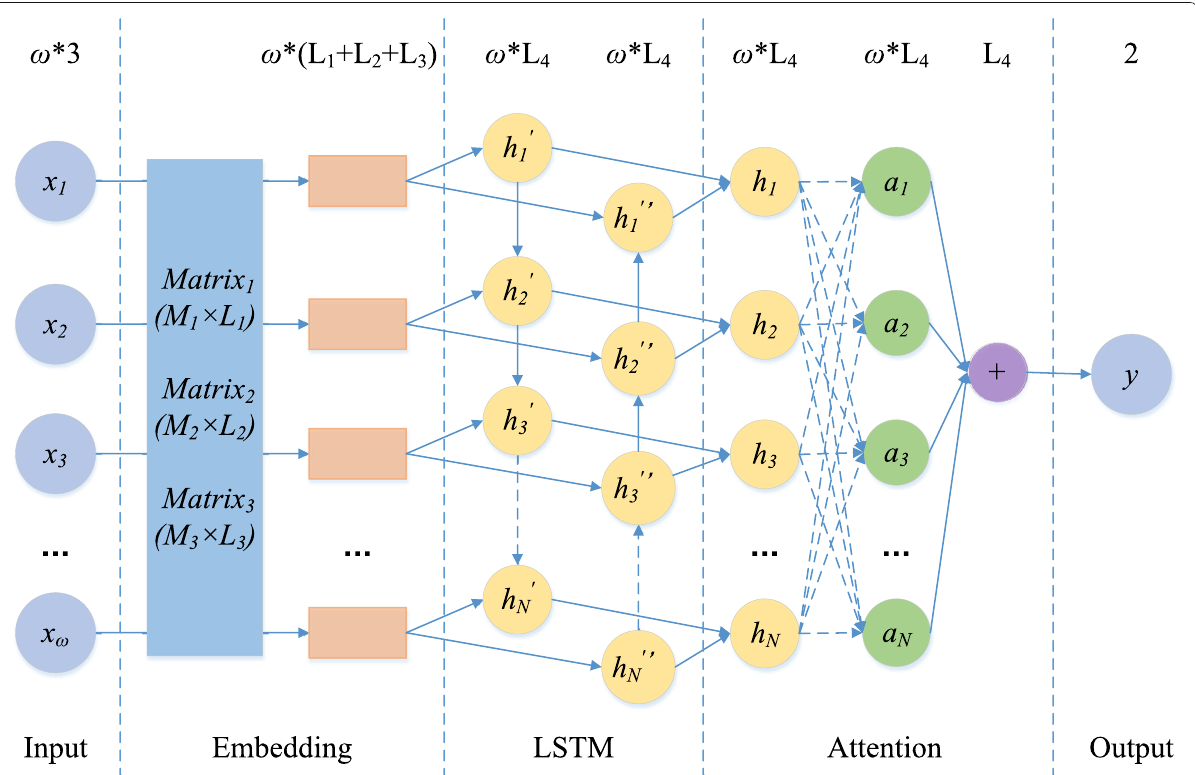
Fig. 2 Network architecture of the keystroke model. Where ω is the length of the keystroke sequence, M 1 is the total number of different keys in the dataset, M 2 is the number of ht , and M 3 is the number of df . L 1 , L 2 , and L 3 are the size of each vector in Matrix 1 , Matrix 2 , and Matrix 3 . and L 4 is the size of hidden